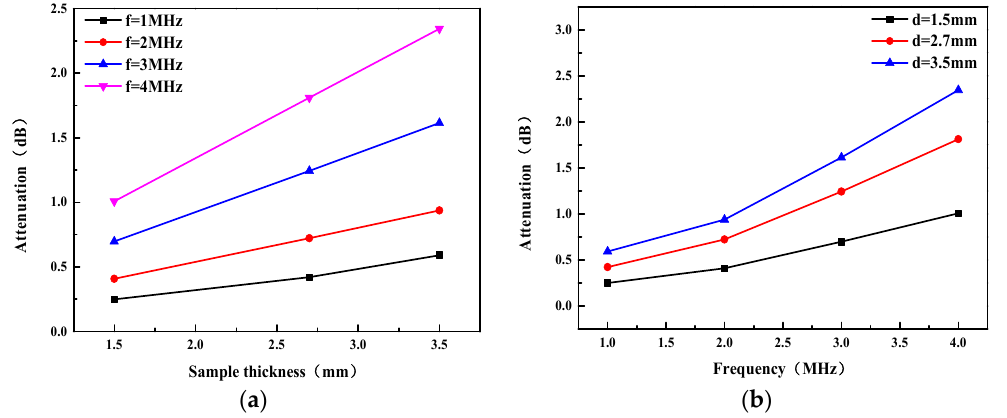
Figure 9. ( a ) Attenuation at representative frequencies as a function of sample thickness; ( b ) Attenuation as a function of frequency for samples with different thickness values.